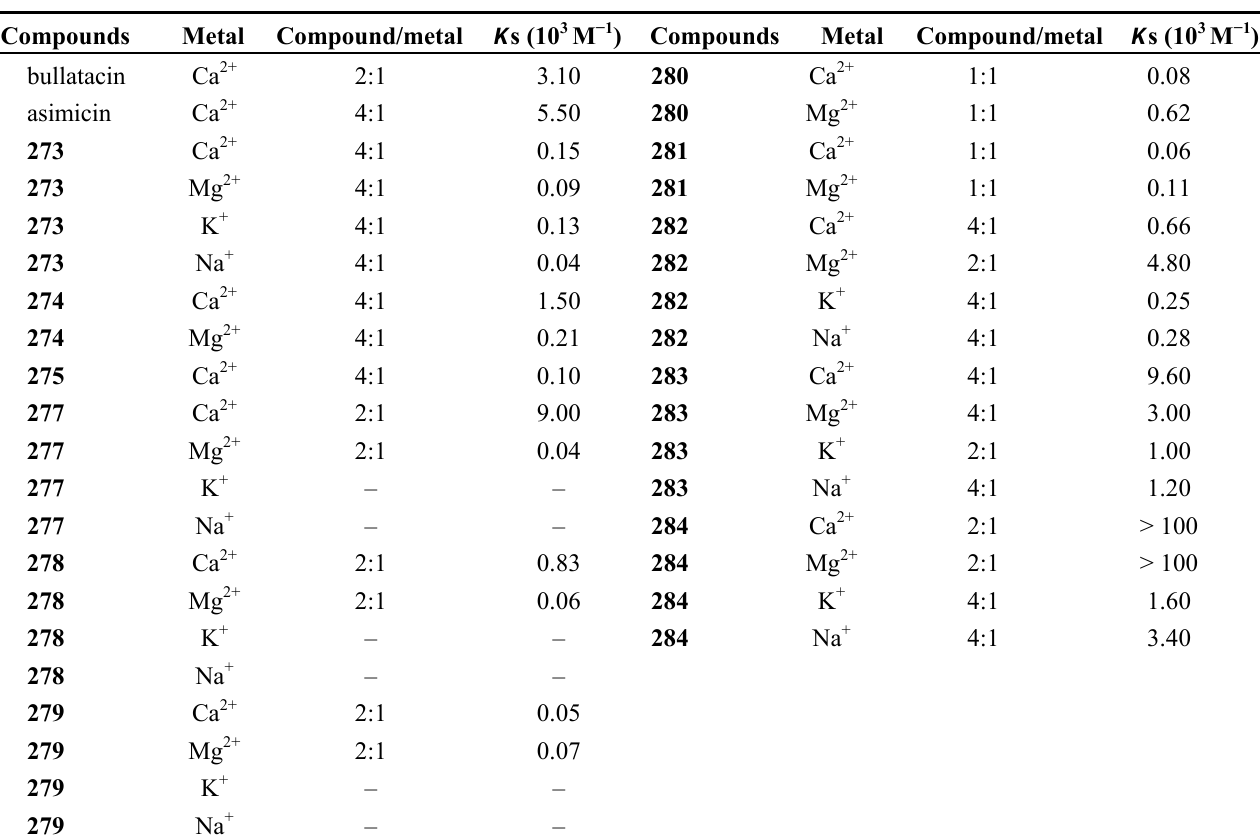
Table 21. Binding properties of the bis-THF